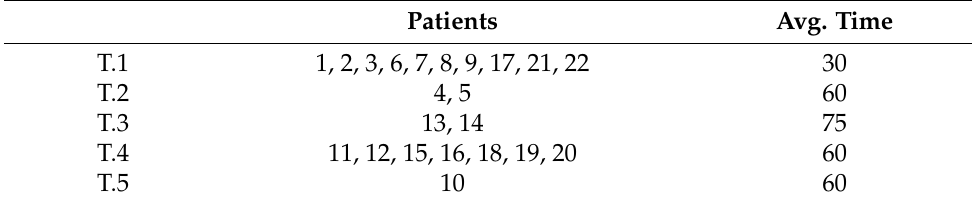
Table 2. Information about the patients and average time associated with each